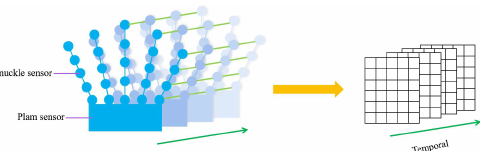
Figure 4. Diagram of the process of constructing the hand spatial-temporal data matrix.